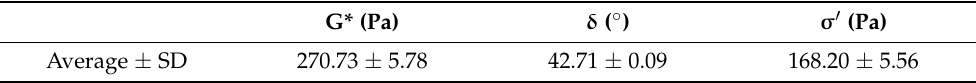
Figure 2. Elastic modulus G’ (triangles), viscous modulus G” (squares), and phase angle δ (circles) of the 3% hypromellose gel loaded with antibiotics. Table 2. Complex modulus G*, phase angle δ , and yield point σ ′ of the 3% hypromellose gel loaded with antibiotics.